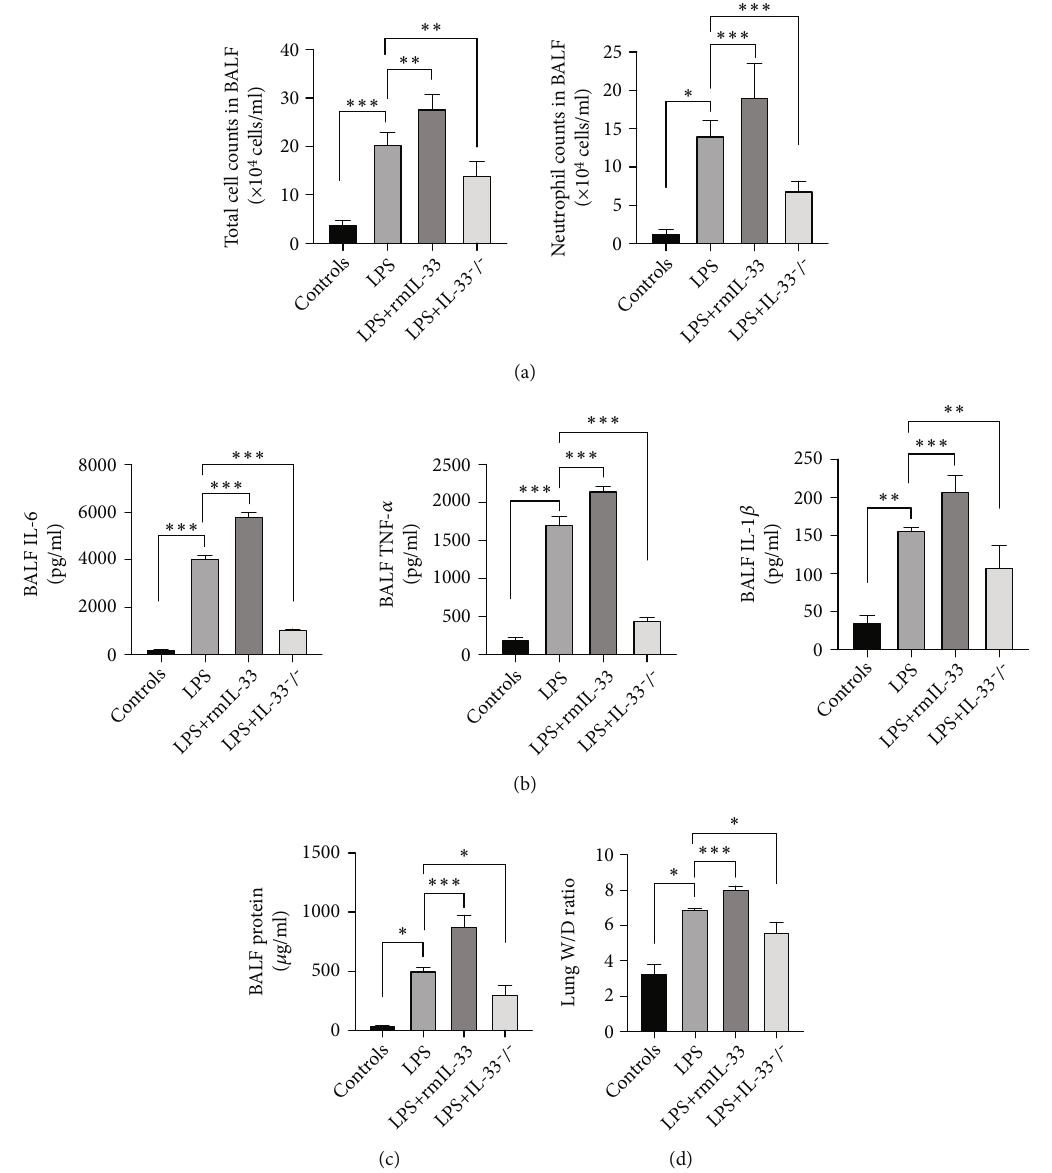
Figure 3: IL-33 de fi ciency diminishes pulmonary in fl ammatory responses in mice with ARDS. (a) Total cell counts and neutrophil counts in BALF. (b) The expression of in fl ammatory mediators, including TNF- α , IL-1 β , and IL-6, in BALF was detected by ELISA. (c) Pulmonary permeability was assessed by BALF protein analysis. (d) Lung tissue edema was measured by the lung W/D ratio. The data are expressed as the means ± SDs . Signi fi cant di ff erences are shown by ∗ P < 0 : 05 , ∗∗ P < 0 : 01 , and ∗∗∗ P < 0 : 001 by one-way ANOVA followed by Bonferroni ’ s post hoc test comparing the WT control, LPS, LPS+rmIL-33, and LPS+IL-33 -/- groups. N = 3 ‐ 5 for each group, and three independent repeated experiments were carried